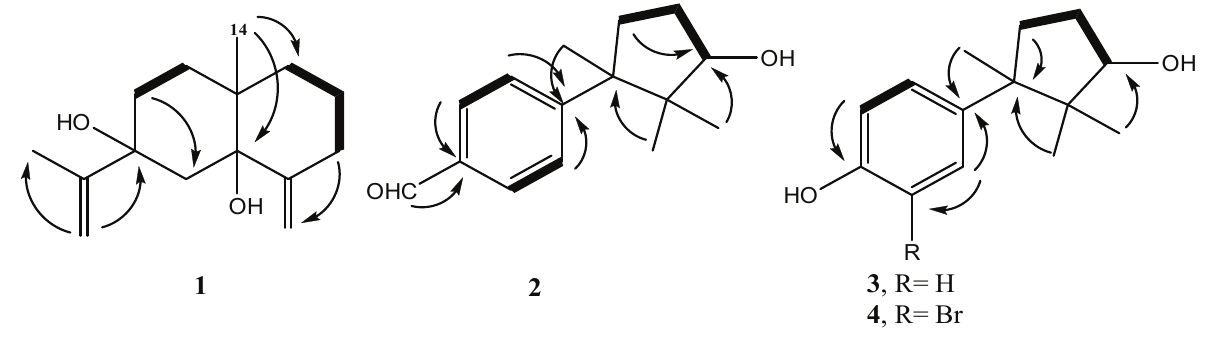
Figure 2. Selected H − H COSY ( ) and HMBC correlations of compounds 1 - 4 ( ). (4)